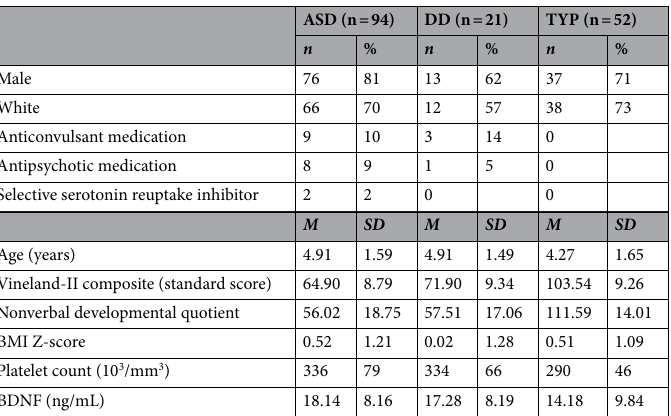
Table 1. Descriptive data. Some data were missing: BMI, n = 9 in ASD, n = 3 in DD, n = 3 in TYP. Platelets, n = 7 in TYP. Psychotropic medications, n = 3 TYP. Eighteen (19%) children in the ASD group, three (14%) in the DD group, and none of the participants in the TYP group had elevated platelets, according to age- and sex-based clinical laboratory reference ranges. Age ranges in the groups were ASD 2.01–9.21 years,